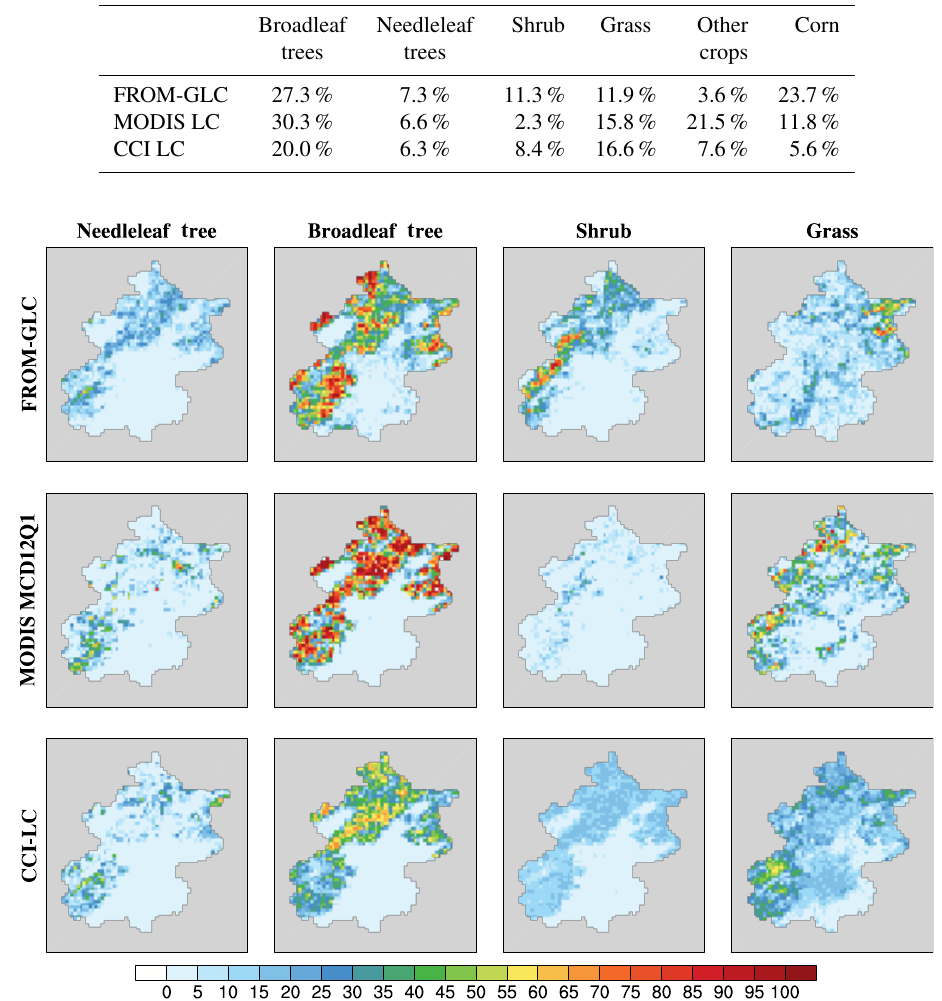
Figure 3. Spatial distribution of the proportions of plant functional types (PFTs) in model grids in the three land cover